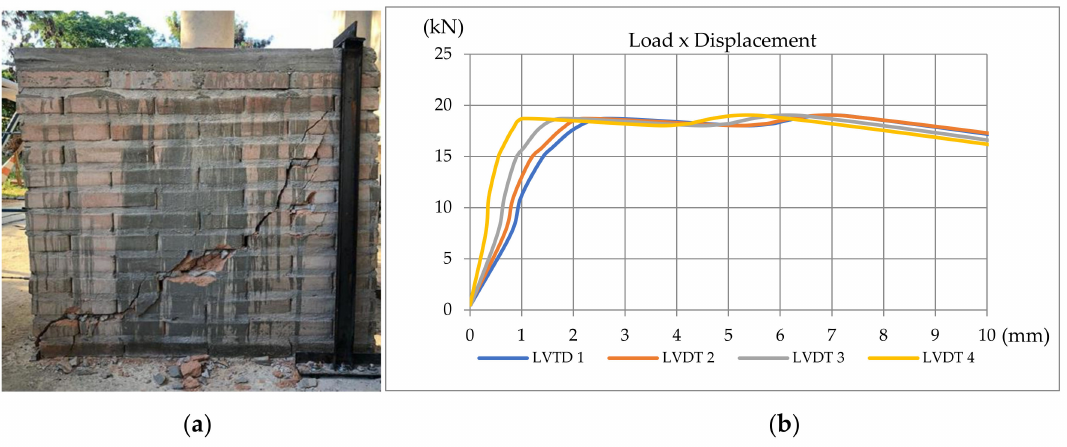
Figure 12. ( a ) Specimen 3; ( b ) Load–displacement curve for Specimen 3 [34].